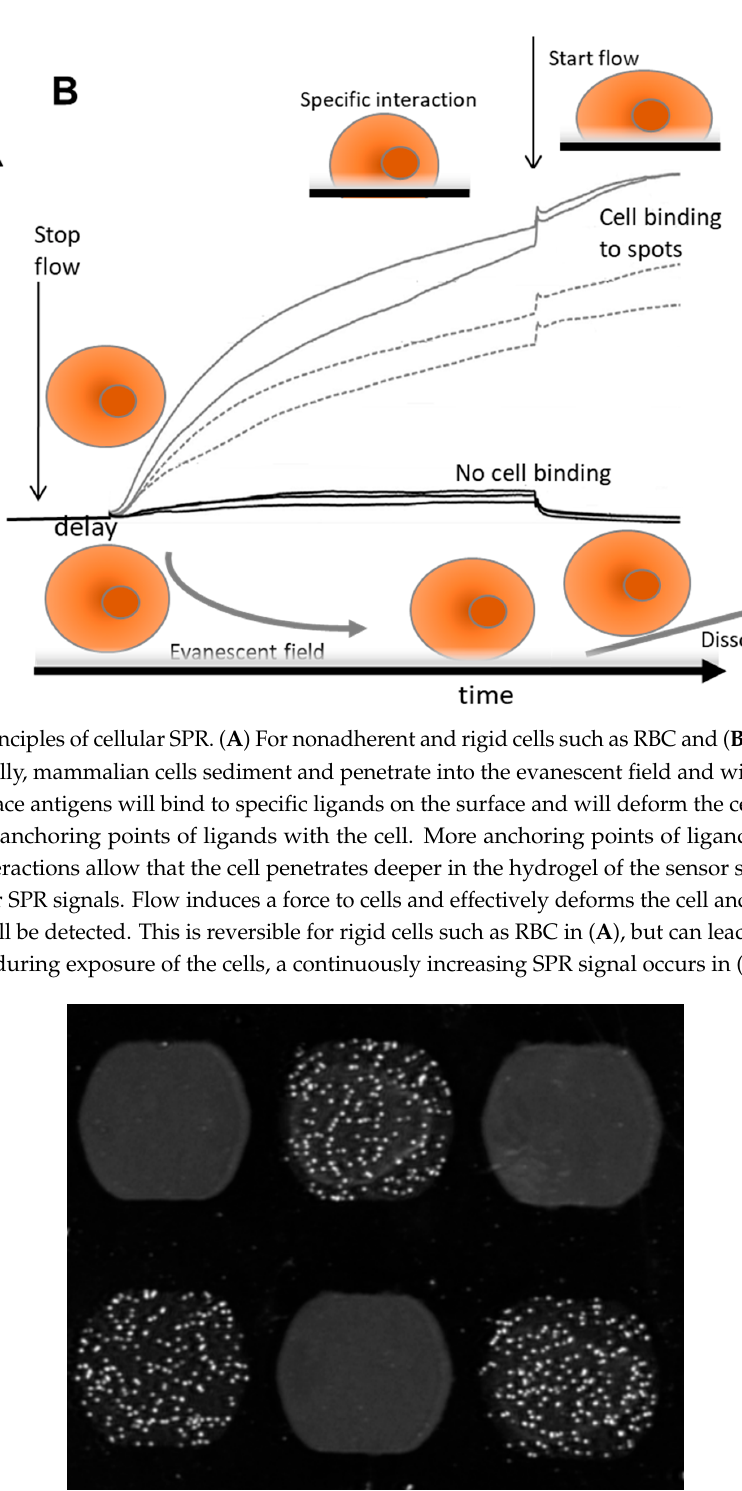
Figure 2. Cells imaged on an SPR sensor. T-lymphocytes are visible in the SPR image on a checkerboard of anti-CD3 spots (with speckles) and BSA spots (grey areas). The image has been taken after the flow started and specific cell binding is observed on anti-CD3 spots and the not-bound cells on BSA spots were washed away. The IBIS MX96 instrument (IBIS Technologies, Enschede, the Netherlands) was used. It contains reversed optics and back and forth flow fluidics, allowing for sedimentation and controlled flow mixing of cells. Valveless injection of samples and wide 1 mm (internal diameter) tubing allows smooth aspiration of cell suspensions without clogging.